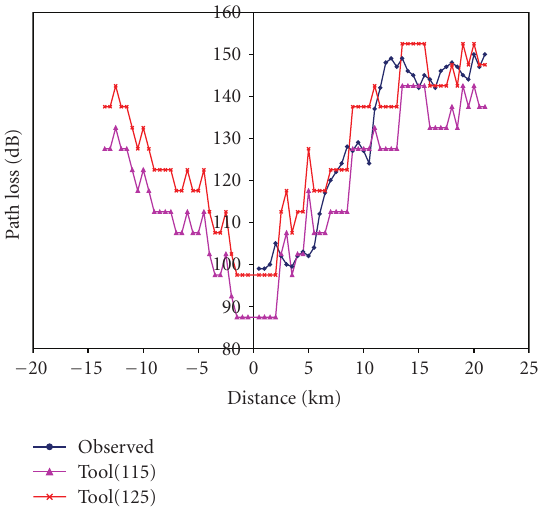
Figure 12: Comparison of tool predicted losses with observed losses versus track distance for Pune base